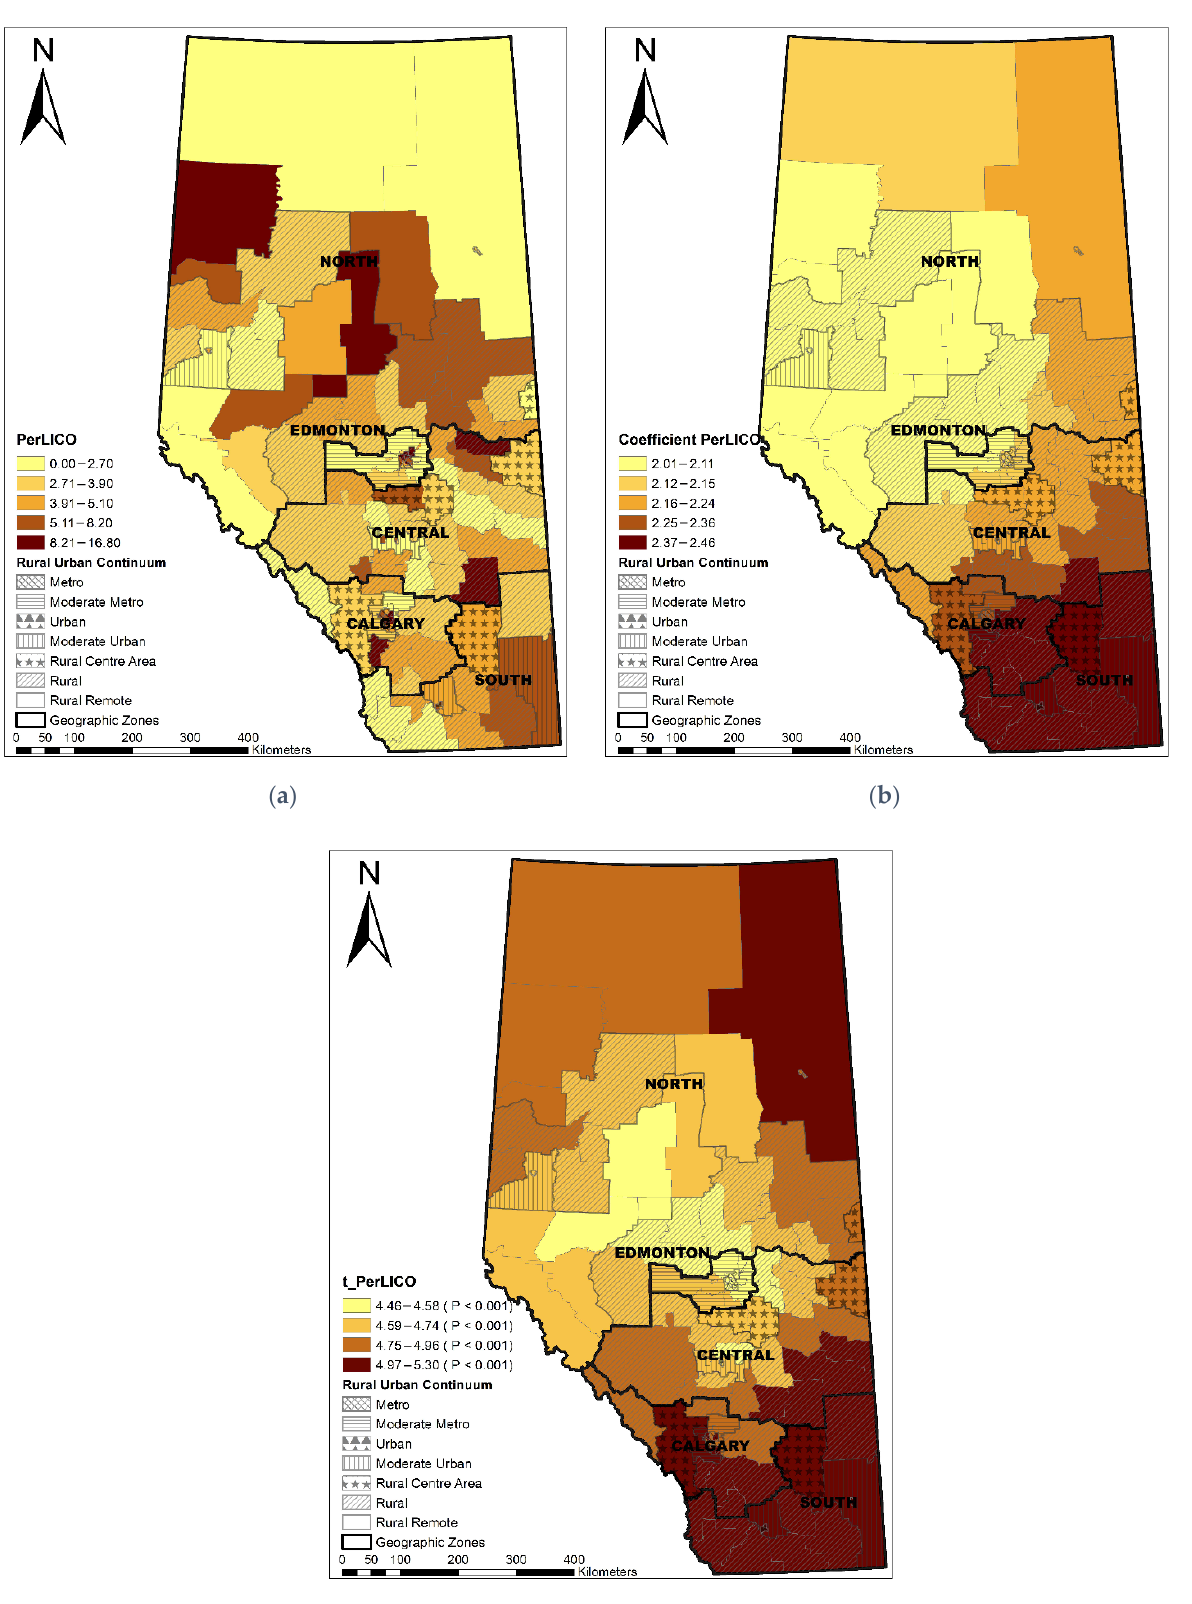
Figure 7. Distribution of percentage of low-income families ( a ), coefficient of percentage of low- income families ( b ), and significance of coefficient ( c ).